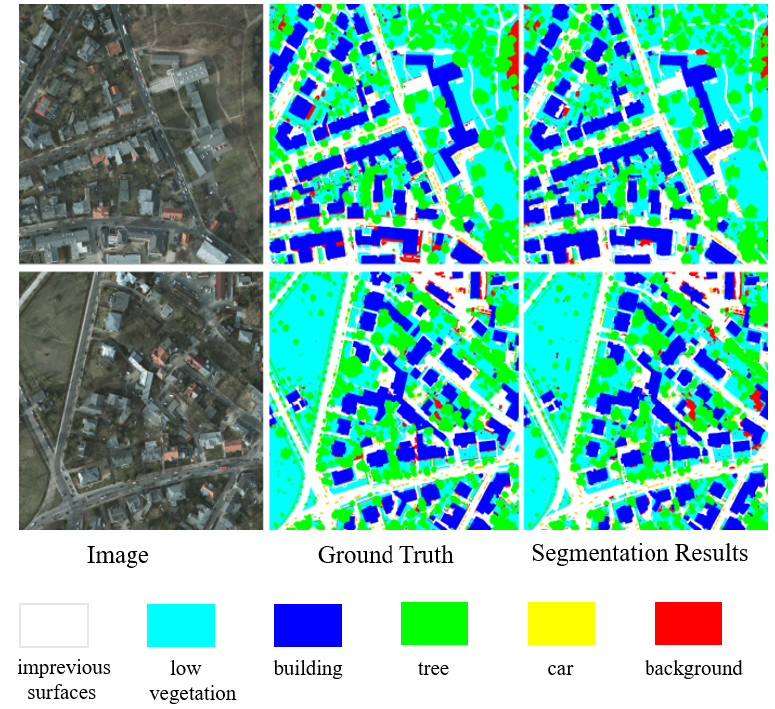
Figure 12. The segmentation results of the MCAFNet on the Potsdam